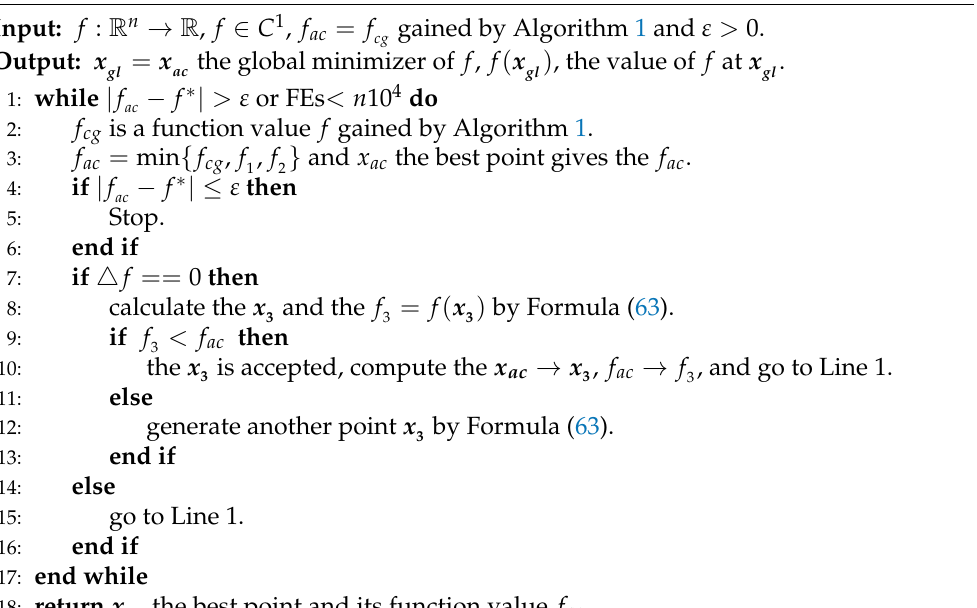
Algorithm 3 Hybrid stochastic CG